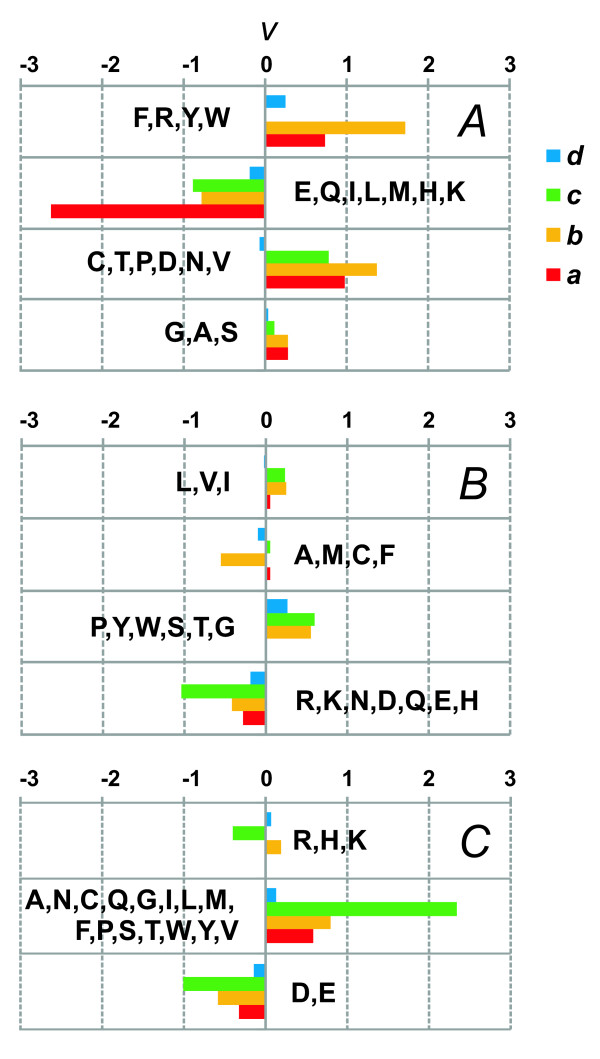
The values of the ν parameter reflecting changes in amino acid frequencies for different evolutionary tree branches for categorizations based on the van der Waals volume, hydropathy and isoelectric point. y-axis, amino acid groups (see Table 4); x-axis, v (see Methods section); branches are labeled as in Figure 2. Property designations: A, van der Waals volume; B, hydropathy; C, isoelectric point.